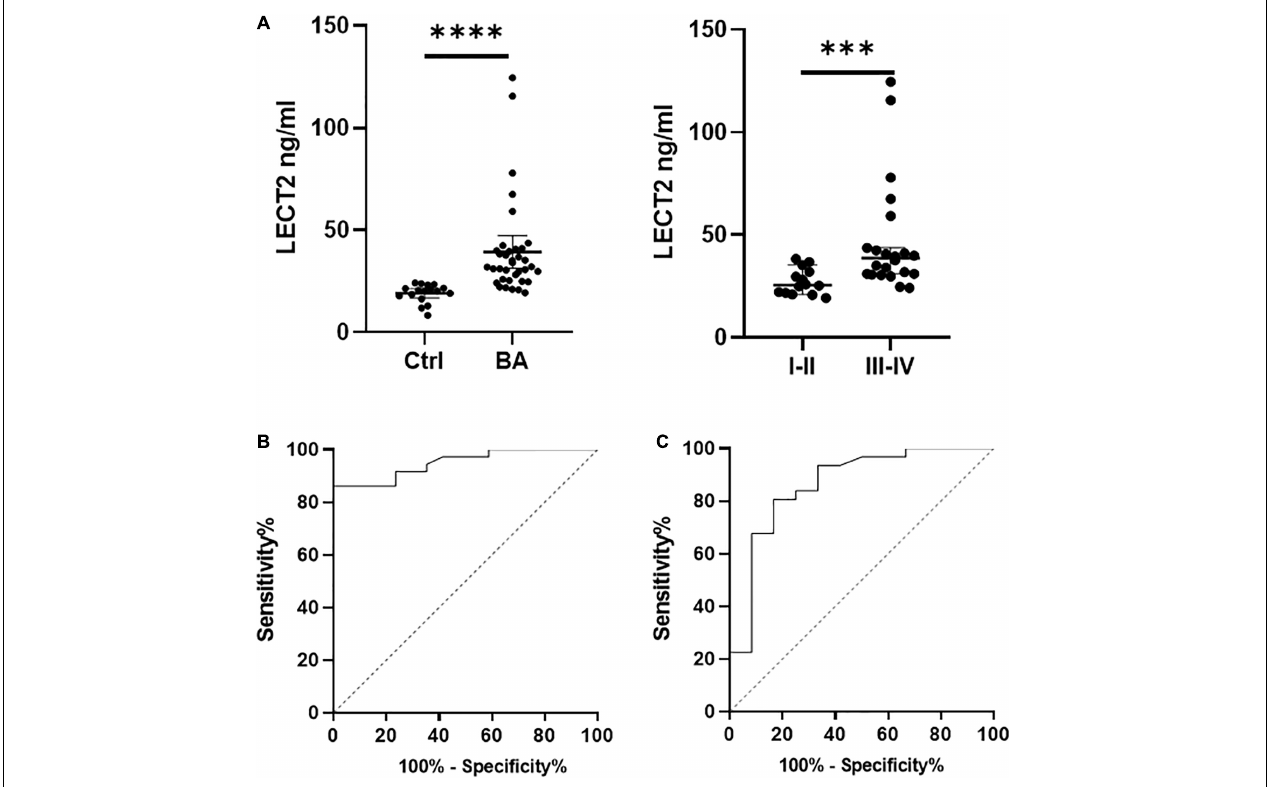
FIGURE 3 | (A) The serum levels of LECT2. (B) The ROC of LECT2. (C) The ROC of GGT. (A) The serum levels of LECT2 in 53 patients. Ctrl: The non-BA infants with jaundice with other causes, including congenital biliary dilations, biliary hypoplasia, and inspissated bile syndrome. The serum levels of LECT2 in the BA group were higher than the control group. In BA group, the LECT2 serum level in patients with severe liver fibrosis was higher than that in those with mild liver fibrosis. LECT2, leukocyte cell-derived chemotaxin 2, I–II, F1/F2; III–IV, F3/F4. (B) The ROC of LECT2 in diagnosing BA. The AUC was 0.95 (95% CI: 0.90–1.00), and the cutoff value was 23.99 ng/ml with a sensitivity of 86% and specificity of 94%. (C) The ROC of GGT in diagnosing BA. The AUC was 0.86 (95% CI: 0.73–1.00), and the cutoff value was 797.5 U/L with a sensitivity of 23% and specificity of 92%. ∗∗∗ p < 0.001, ∗∗∗∗ p < 0.0001.